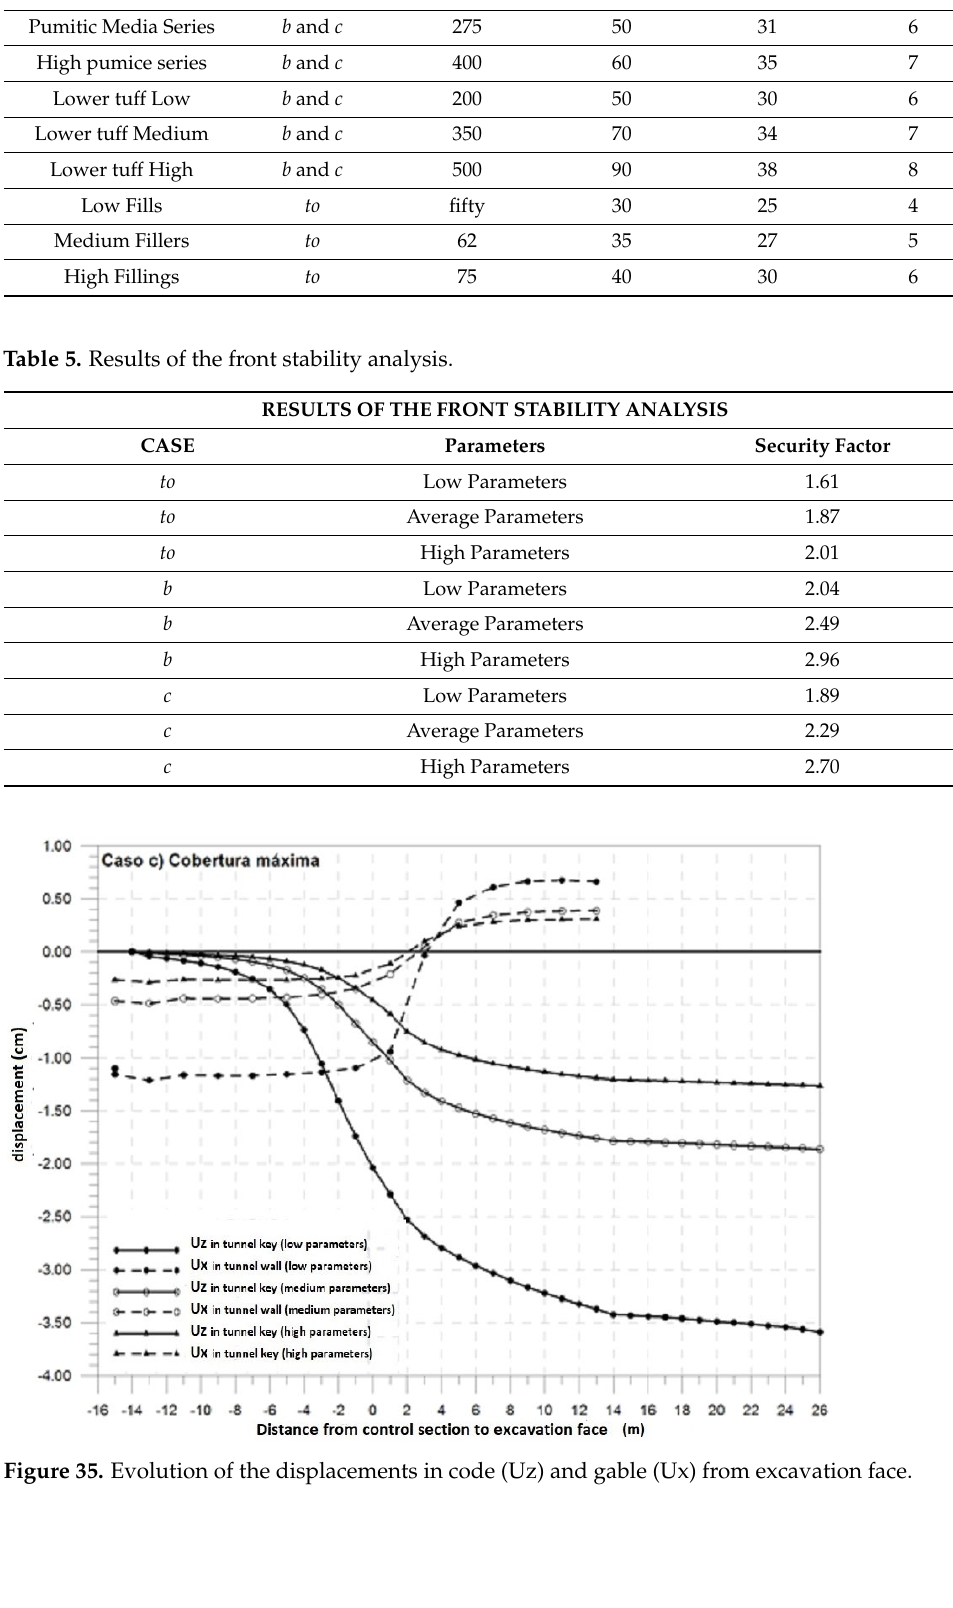
Table 4. Basic parameters for the front stability analysis.